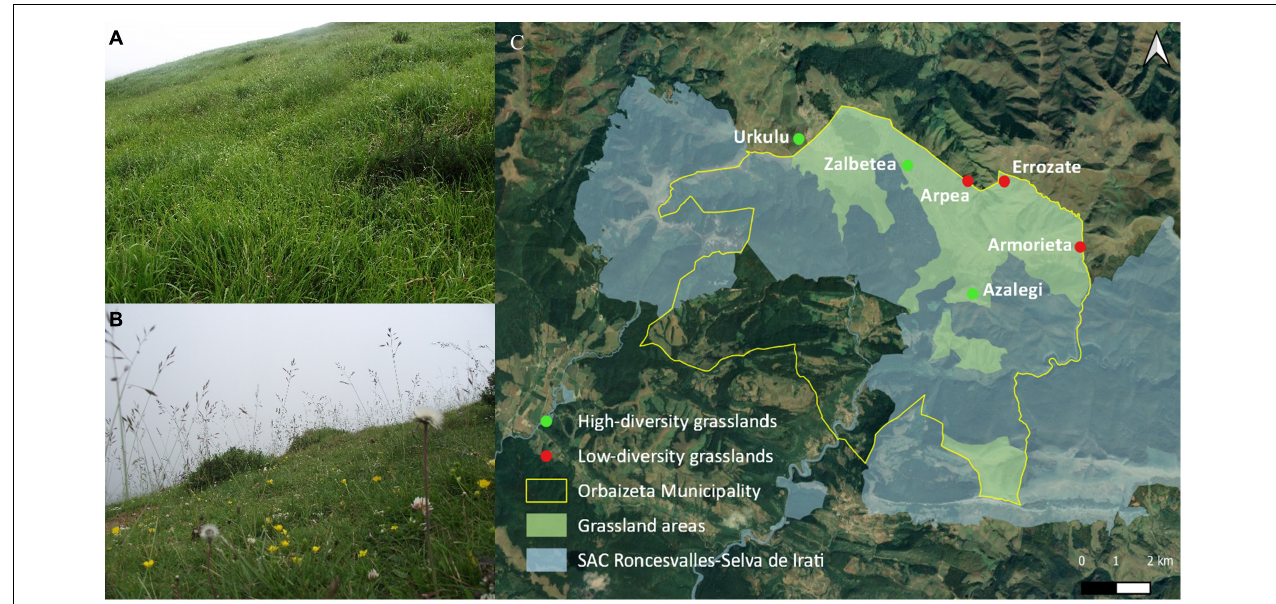
FIGURE 1 | Locations selected for collecting plants. Red points represent low-diversity grasslands and green points high-diversity grasslands (C) . Pictures of the Brachypodium rupestre invaded (A) and non-invaded (B) areas.